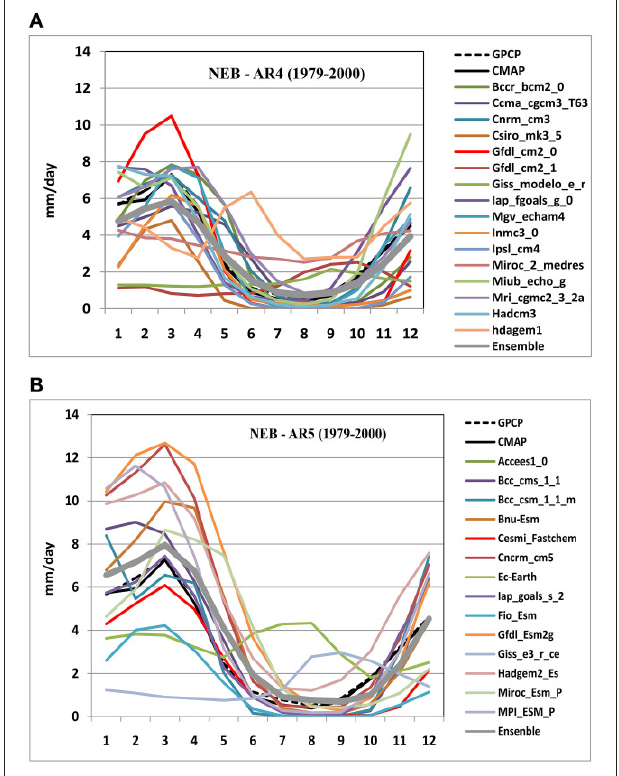
FIGURE 2 | Annual rainfall cycle observed (GPCP and CMAP) for the NEB over the period 1979–2000 and simulated CMIP3-AR4 (A) CMIP5-AR4 (B)